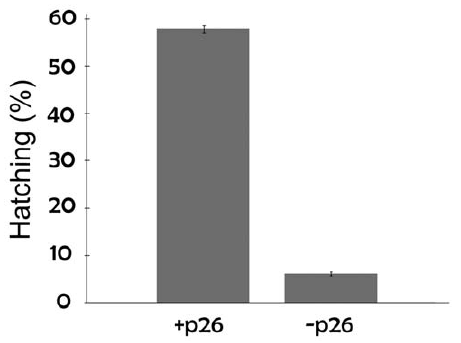
Figure 6. p26 enhances the stress tolerance of Artemia cysts. The diapause of Artemia cysts either containing ( + p26) or lacking ( 2 p26) p26 was terminated by desiccation and freezing. The cysts were then incubated in sea water at room temperature and hatched nauplii were counted and removed. The results are given as the percentage of cysts that hatched which was taken as the level of diapause termination and cyst viability. The experiment was done in triplicate with separate broods of cysts and the error bars represent standard error.